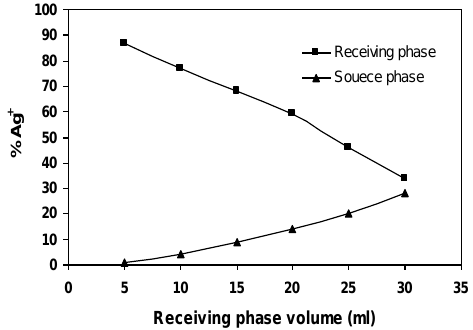
Figure 6. Effect of receiving phase volume on Ag + caion transport. Experimental conditions: source phase, 10 ml of 3.0×10 -4 M Ag + cation and 3.0×10 -3 M picric acid at pH 4; liquid membrane phase, 50 ml of 1.0×10 -3 M carrier in DCM; receiving phase, varying volume of 1.0×10 -3 M S O 32- at pH 3; time of transport, 4 hours. 2